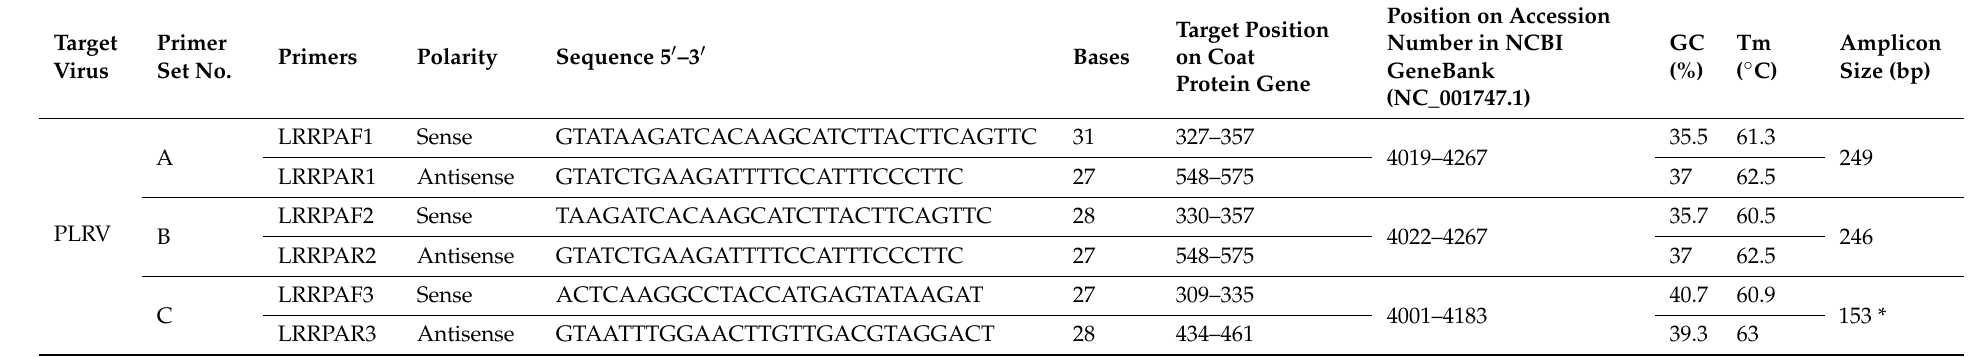
Table 1. Primers utilized in this research study with the aim of optimizing a one-step reverse transcription-recombinase polymerase amplification (RT-RPA) technique.